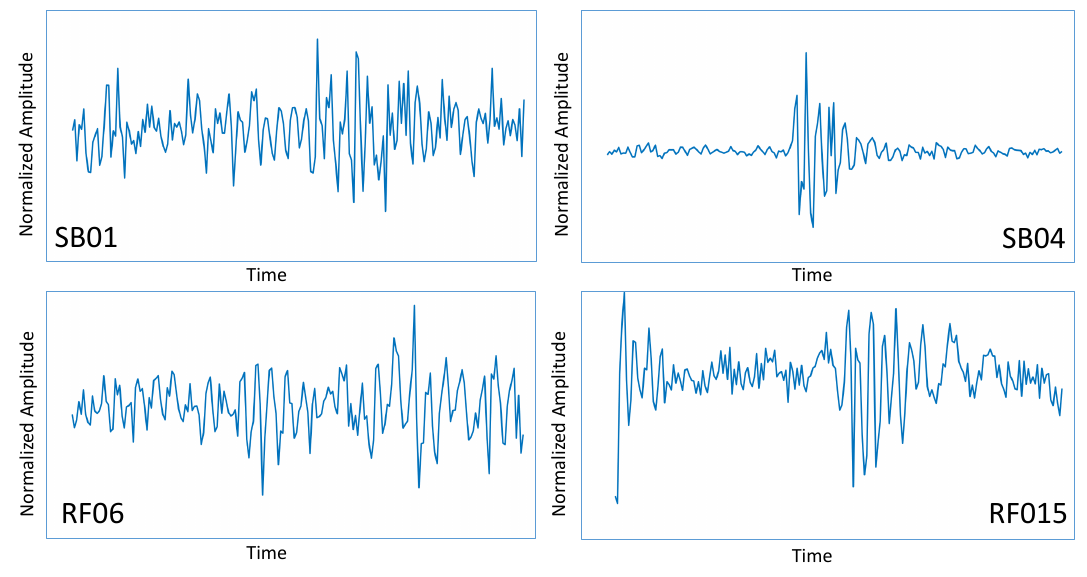
Figure 4. Examples of obstacles and road anomalies (recordings with the accelerometer in the Z vertical direction).